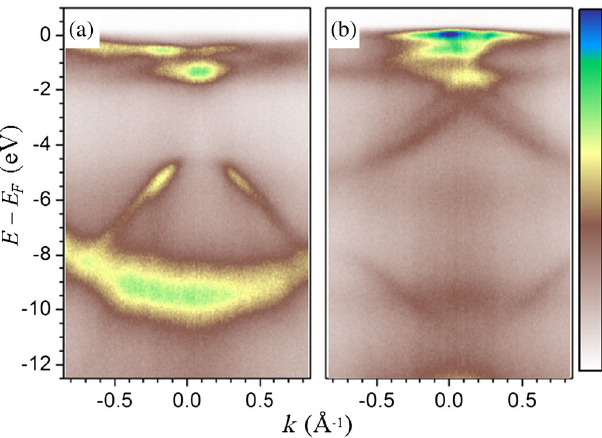
FIG. 6. Electronic band structures of the graphene with a low coverage of Na atoms taken at (a) the Γ and (b) the K